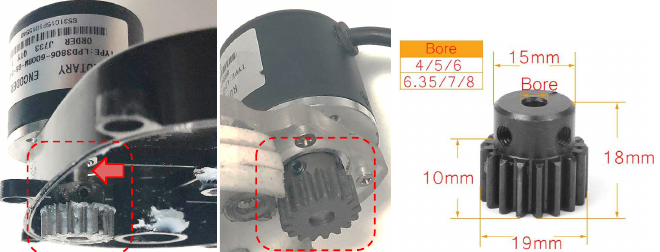
Figure 5. The spur gear for steering and driving encoder. ( Left ) Steering motor encoder. The spur gear is affixed with a 7 mm gap from the casing. The arrow indicates the gap. ( Center ) Driving motor encoder. The spur gear is mounted without a gap from the casing. ( Right ) The dimensions of the spur gear; 17 teeth spur gear and 7 mm bore